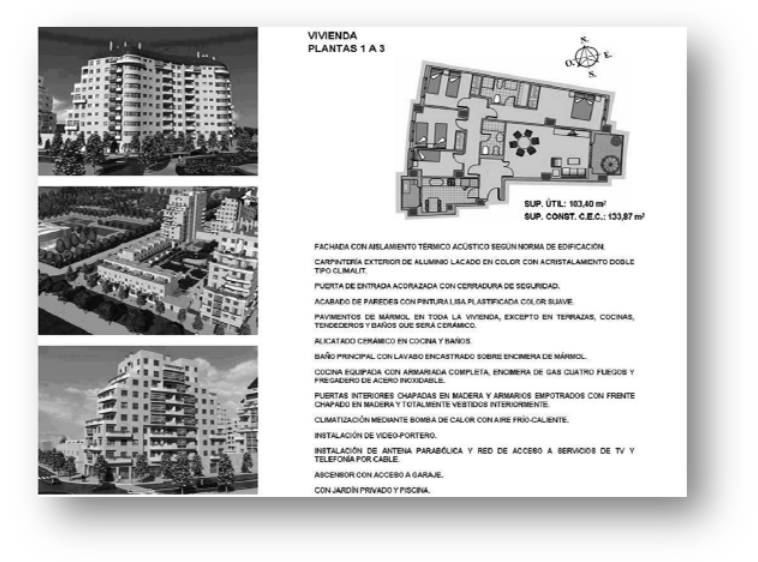
Figure 1. “Example of the stimuli used in the field study”. Source: authors